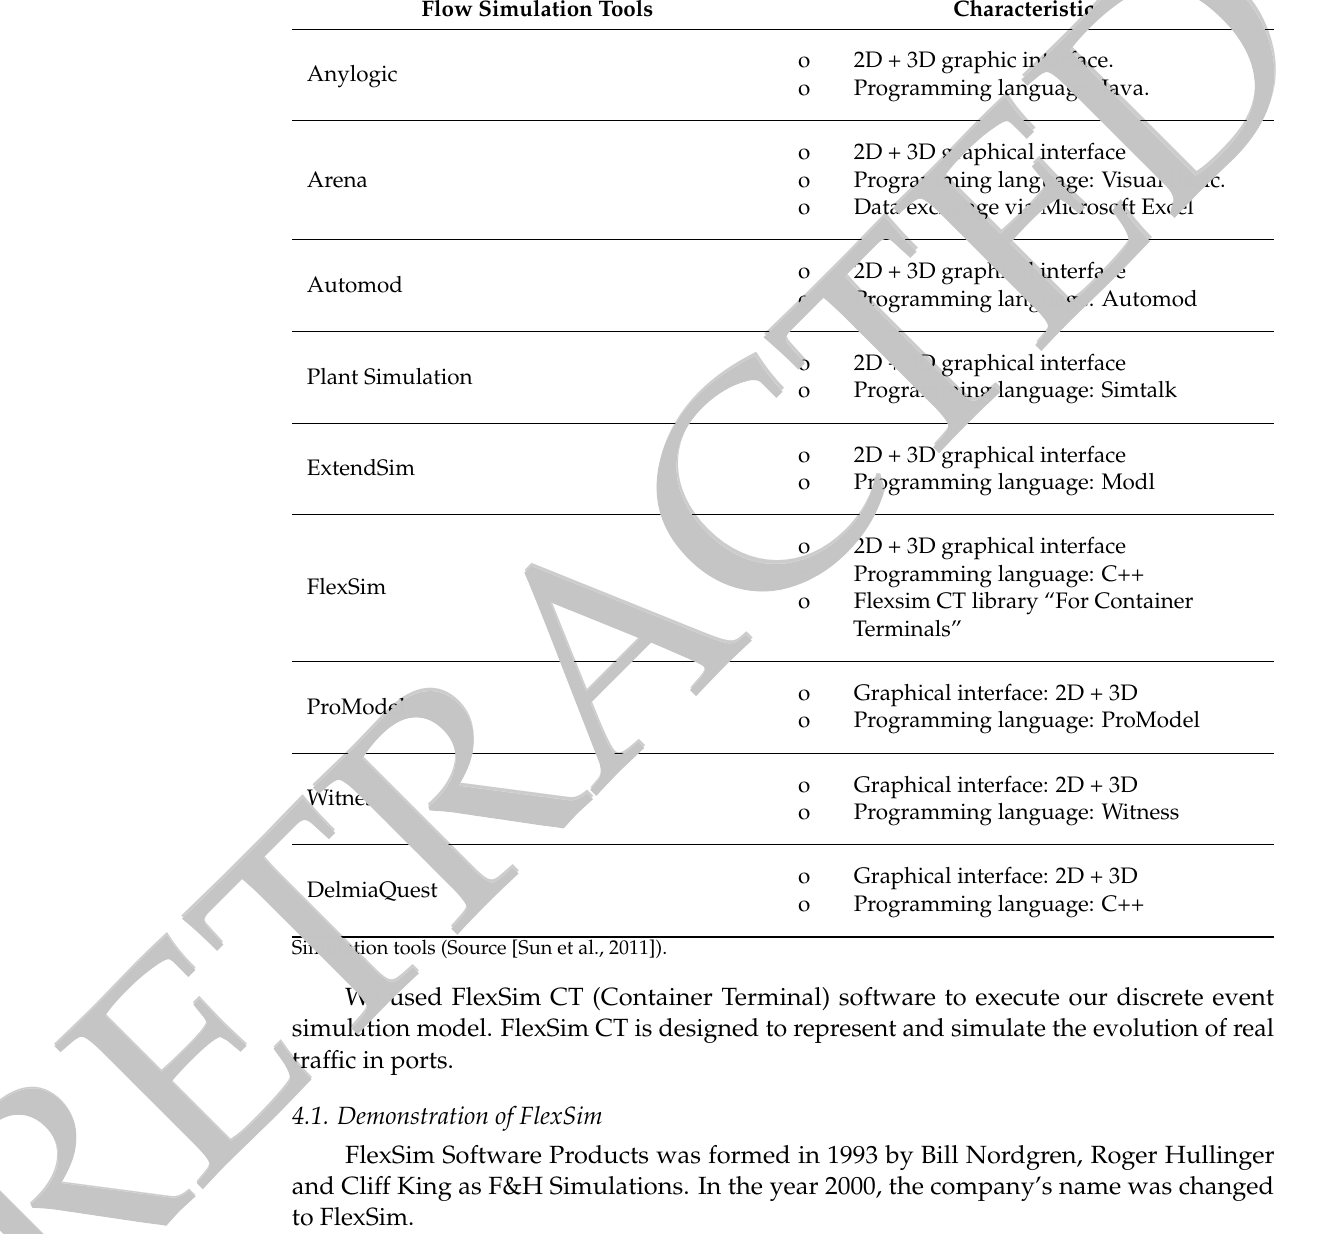
Table 1. Comparison of commonly used simulation software [Sun et al., 2011]. Flow Simulation Tools